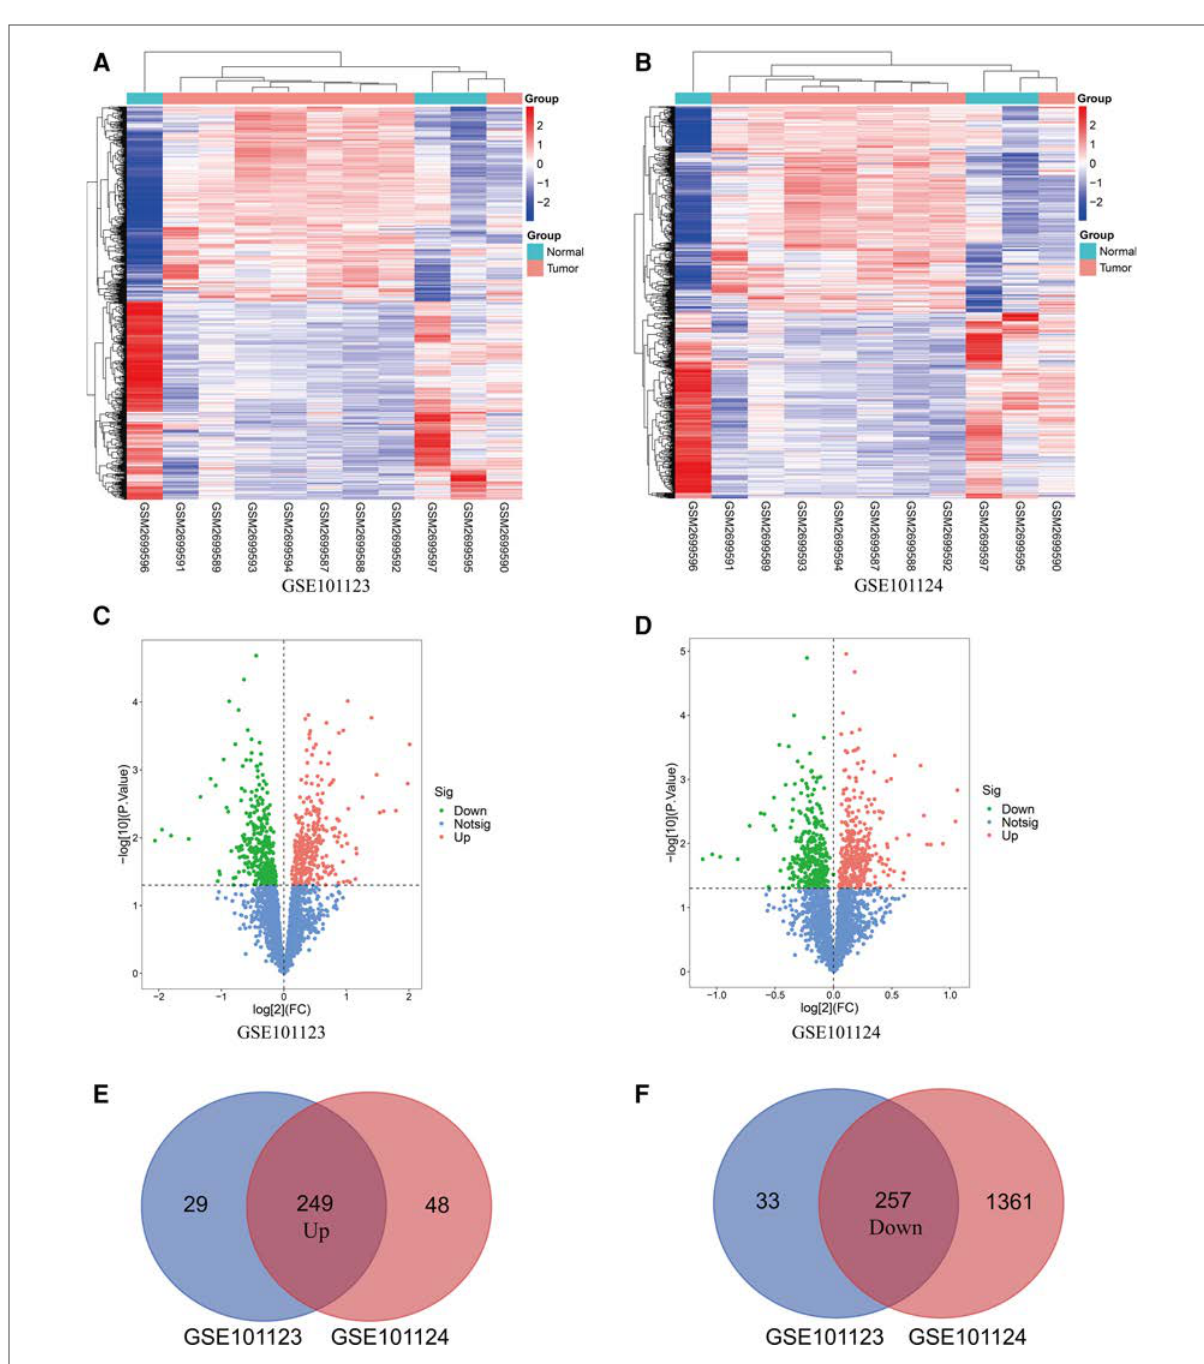
FIGURE 2 Differentially expressed circRNAs in BC patients compared with the Normal group. ( A,B ) Heatmap of the differentiallyexpressed circRNAs in BC based on GSE101123 and GSE101124. ( C,D ) Volcano map for all circRNAs in GSE101123 and GSE101124. ( E,F ) Overlap in DE circRNAs between GSE101123 and